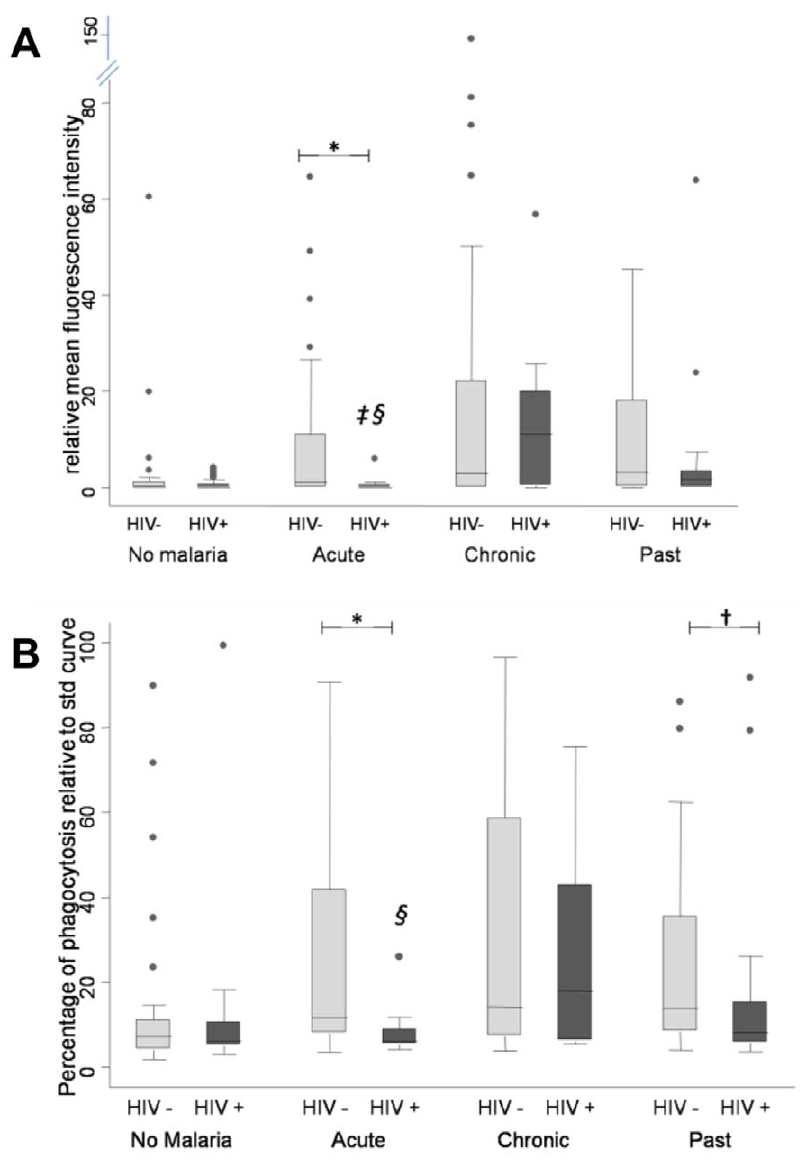
Figure 3. Antibodies across histopathology groups of placental malaria. Antibody measurements across histopathology of placental malaria groups. Light grey bars – HIV negative (HIV 2 ), dark grey bars – HIV positive (HIV=). A) Total VSA IgG to CS2. Mann-Whitney ranksum tests performed on HIV 2 women: 1 acute vs chronic p =0.018, { acute vs past: p =0.038. Mann-Whitney ranksum tests performed between HIV 2 and HIV + women: * acute group: p =0.028. B) phagocytic antibodies’ function. Mann-Whitney ranksum tests performed on HIV- women: 1 acute vs chronic p =0.034. Mann-Whitney ranksum tests performed between HIV 2 and HIV + women: * acute group: p =0.013, { past group: p =0.07. Bars represent median and interquartile ranges. Whiskers represent 95% CI. Dots represent outliers.